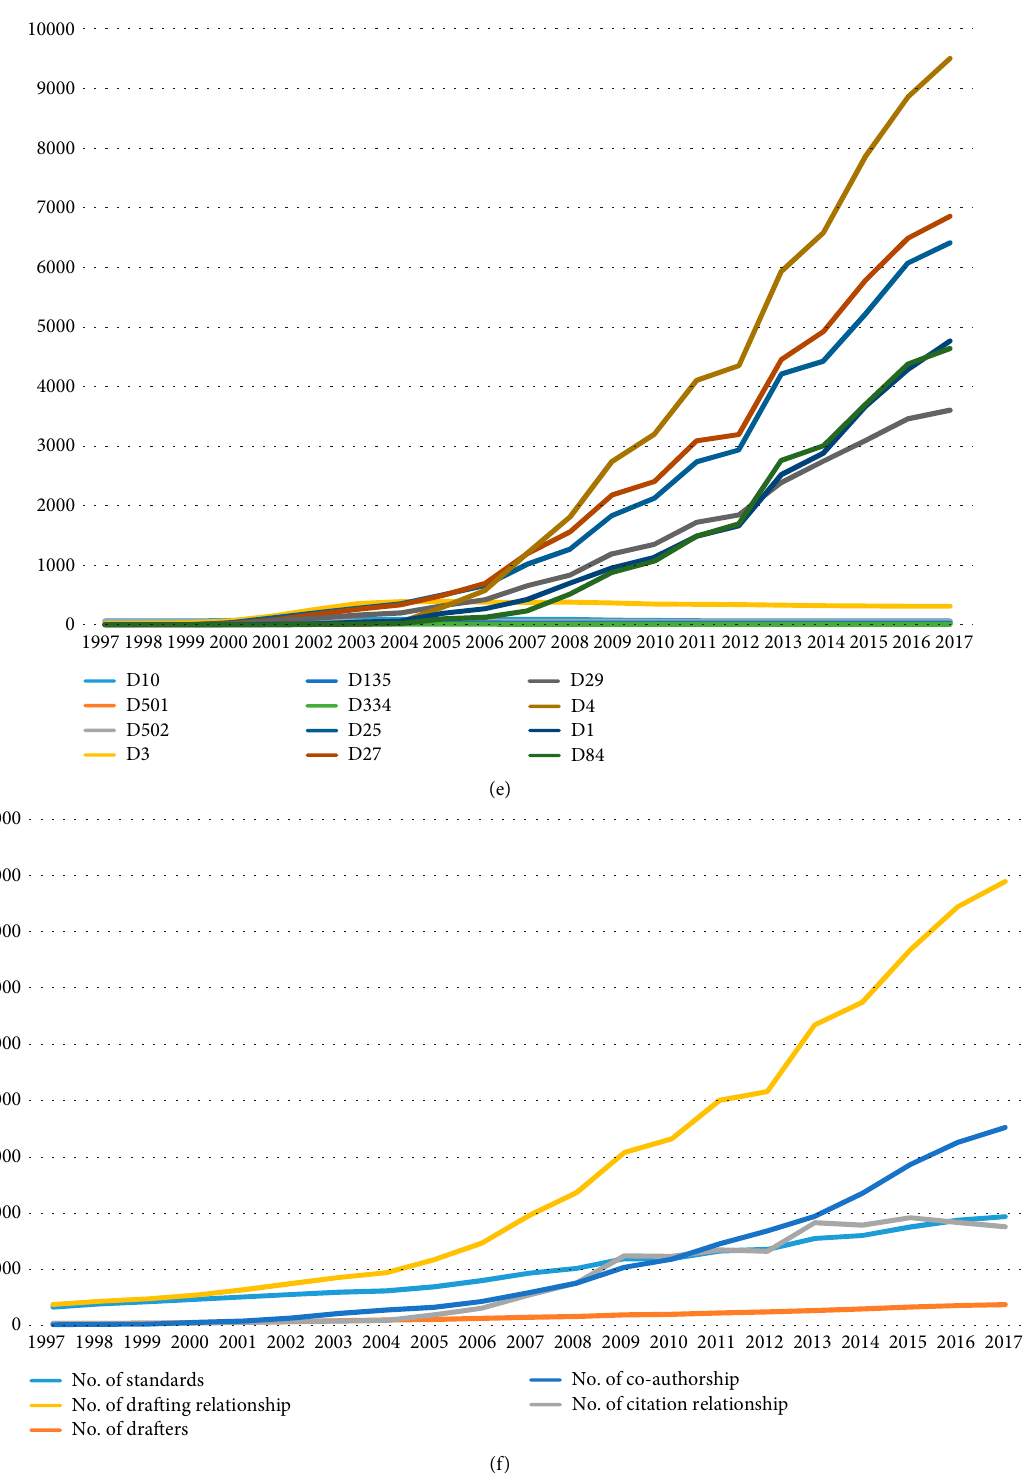
Figure 7: Dynamic changes in metrics communications standards network. Dynamic changes in (a) most highly-cited standards, (b) drafters with the greatest participation degree, (c) drafters with the greatest contribution degree, (d) drafters with the greatest cooperation degree, (e) drafters with the greatest co-authorship degree, and (f) the network